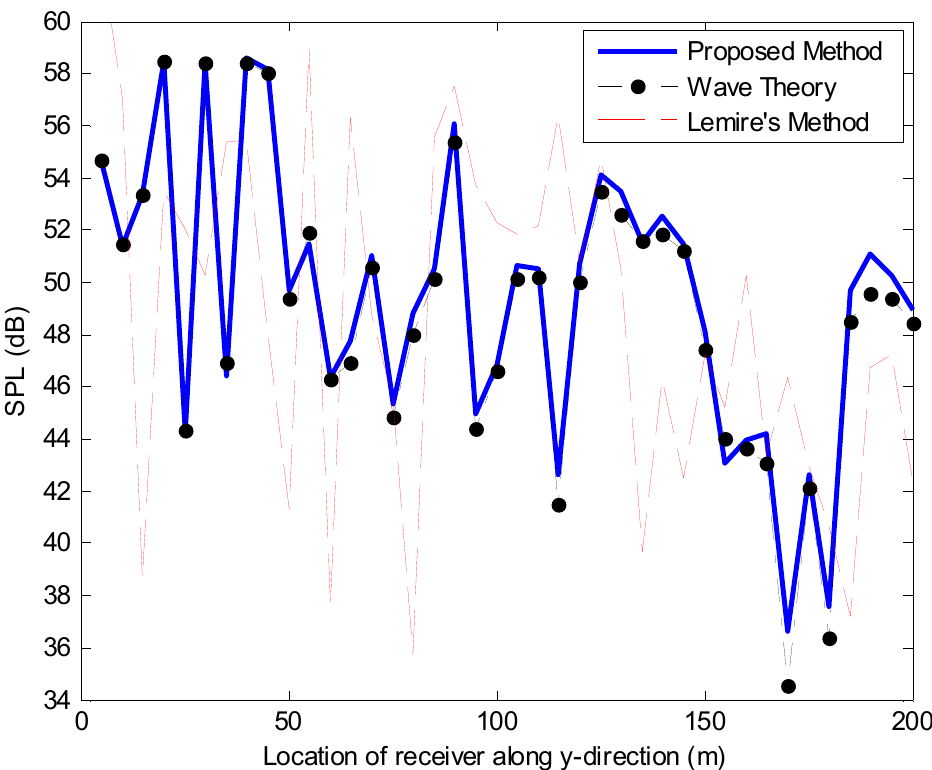
Figure 4. Comparison of predictions on sound pressure level (SPL) at frequency of 1000 Hz vs. the receiver location along the y-direction. The source is located at (6 m, 0 m, 1 m) and the receiver is located at (6 m, yr, 1 m) with yr moving from 5 m to 200 m. The solid line represents the results with the proposed method, the solid circles with a dot-dash line are those with the wave theory that is considered the benchmark, and the dash line is the result with the method of Lemire and Nicolas (Lemire’s method).